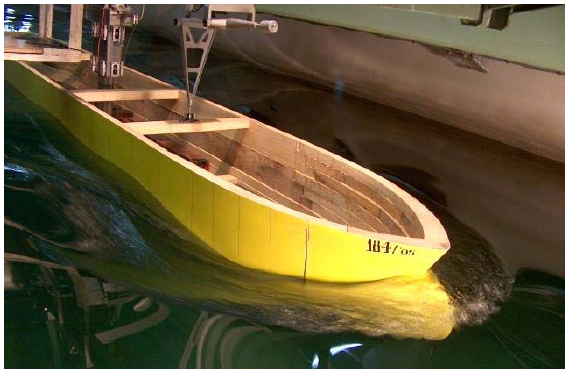
Figure 3. Scale model of the bulk ‐ carrier in the towing tank of LSMH ‐ NTUA.